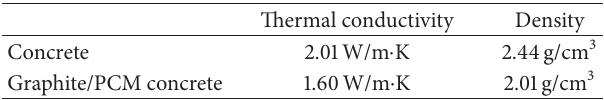
Table 1: Thermal conductivity and density of concrete and graphite/ PCM concrete.